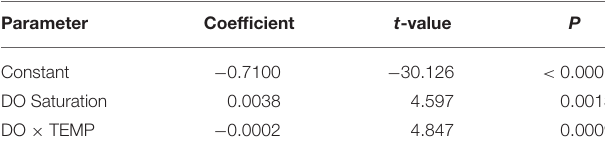
TABLE 1 | Non–linear regression model parameters.